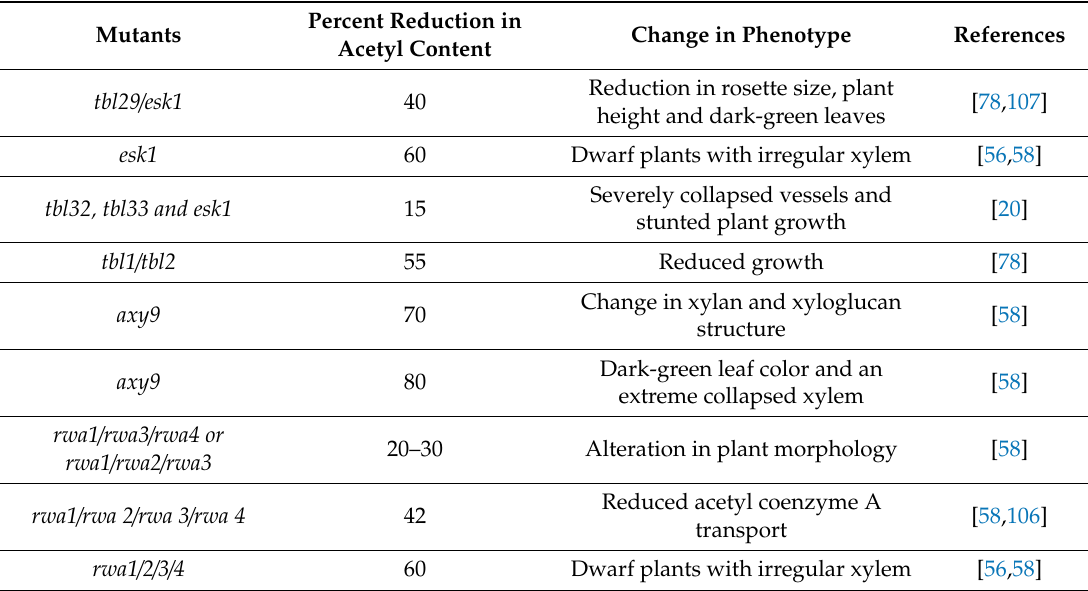
Table 1. Change in acetyl content and alteration in plant phenotypes in various plant mutants and transgenic